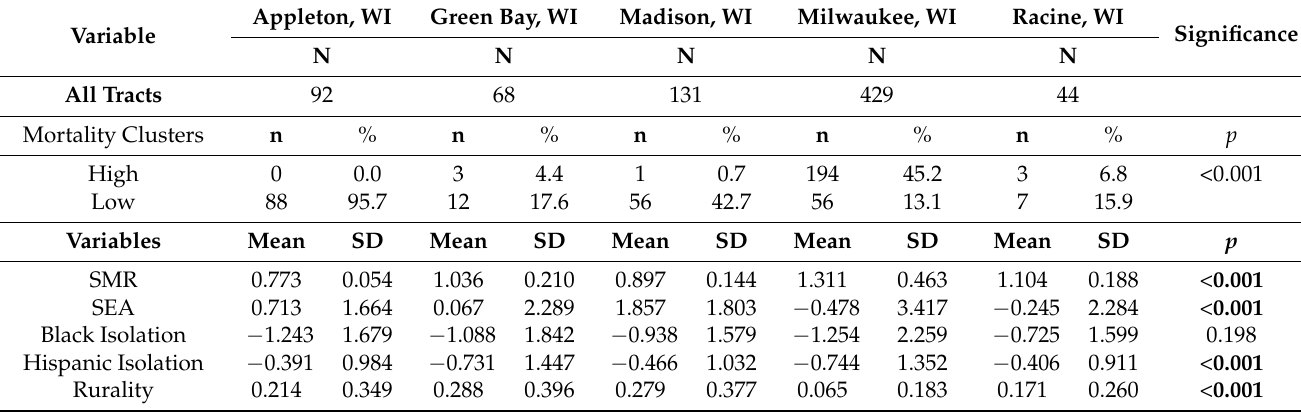
Table 1. Comparisons of the Wisconsin MSAs included in the study. The top portion of the table compares the number of tracts which are mortality hotspots and coldspots across the different MSAs. The p -value reported is for chi-squared testing. The bottom portion of the table shows mean and standard deviations of the continuous variables in this study: liver cancer SMR, SEA, localized Black and Hispanic isolation, and the proportion of rural tracts. The p -values reported for these variables are based on Kruskal–Wallis testing across MSAs. Bolded p -values indicate statistical significance of p < 0.05. Abbreviations: MSA: Metropolitan Statistical Area, SMR: Standardized Mortality Ratio, SEA: Socioeconomic Advantage, SD: Standard